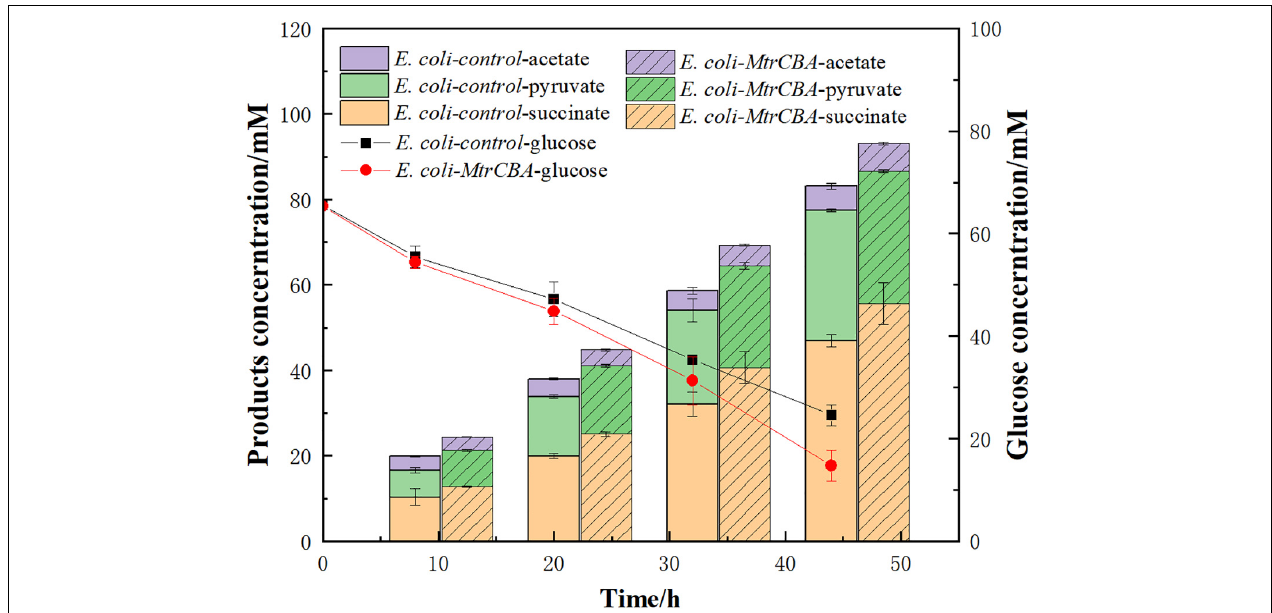
FIGURE 1 | Effects of the exogenous electrons on major metabolite profiles. Bioelectrochemical reactors inoculated with E. coli-control or E. coli-MtrCBA (OD 600 = 1) in cathode mediums were imposed at a constant potential [-0.8 V (vs.